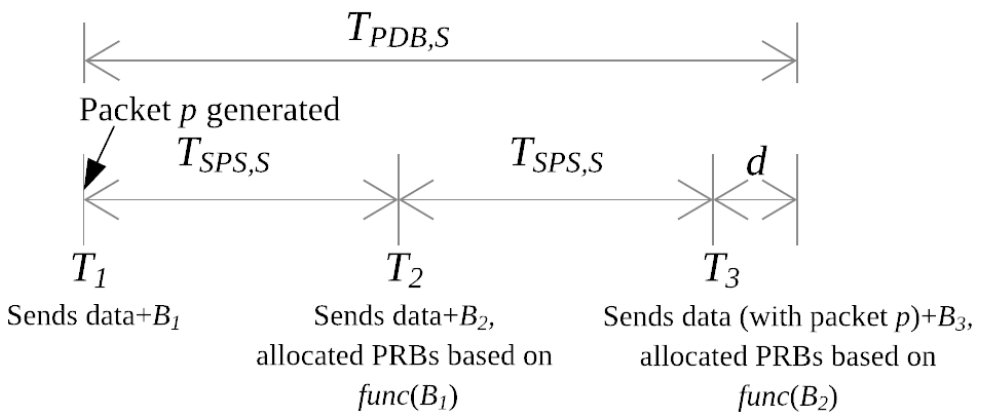
Figure 2. Worst case packet delay for traffic class S